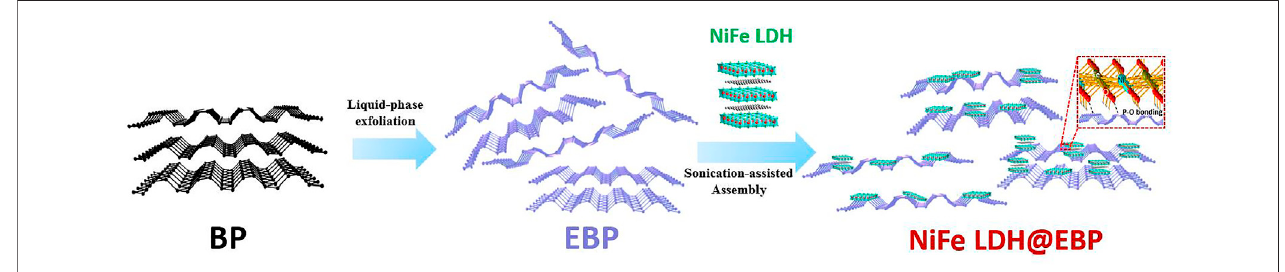
FIGURE 1 | Schematic illustration for the preparation of NiFe